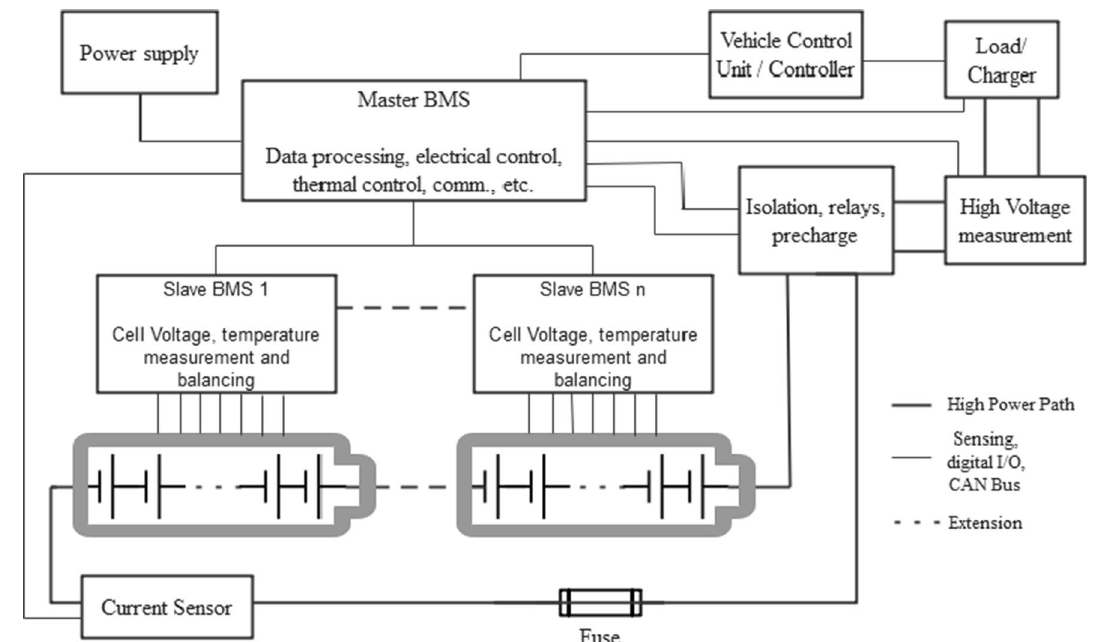
Fig. 5 Example of a basic BMS architecture and the functional safety